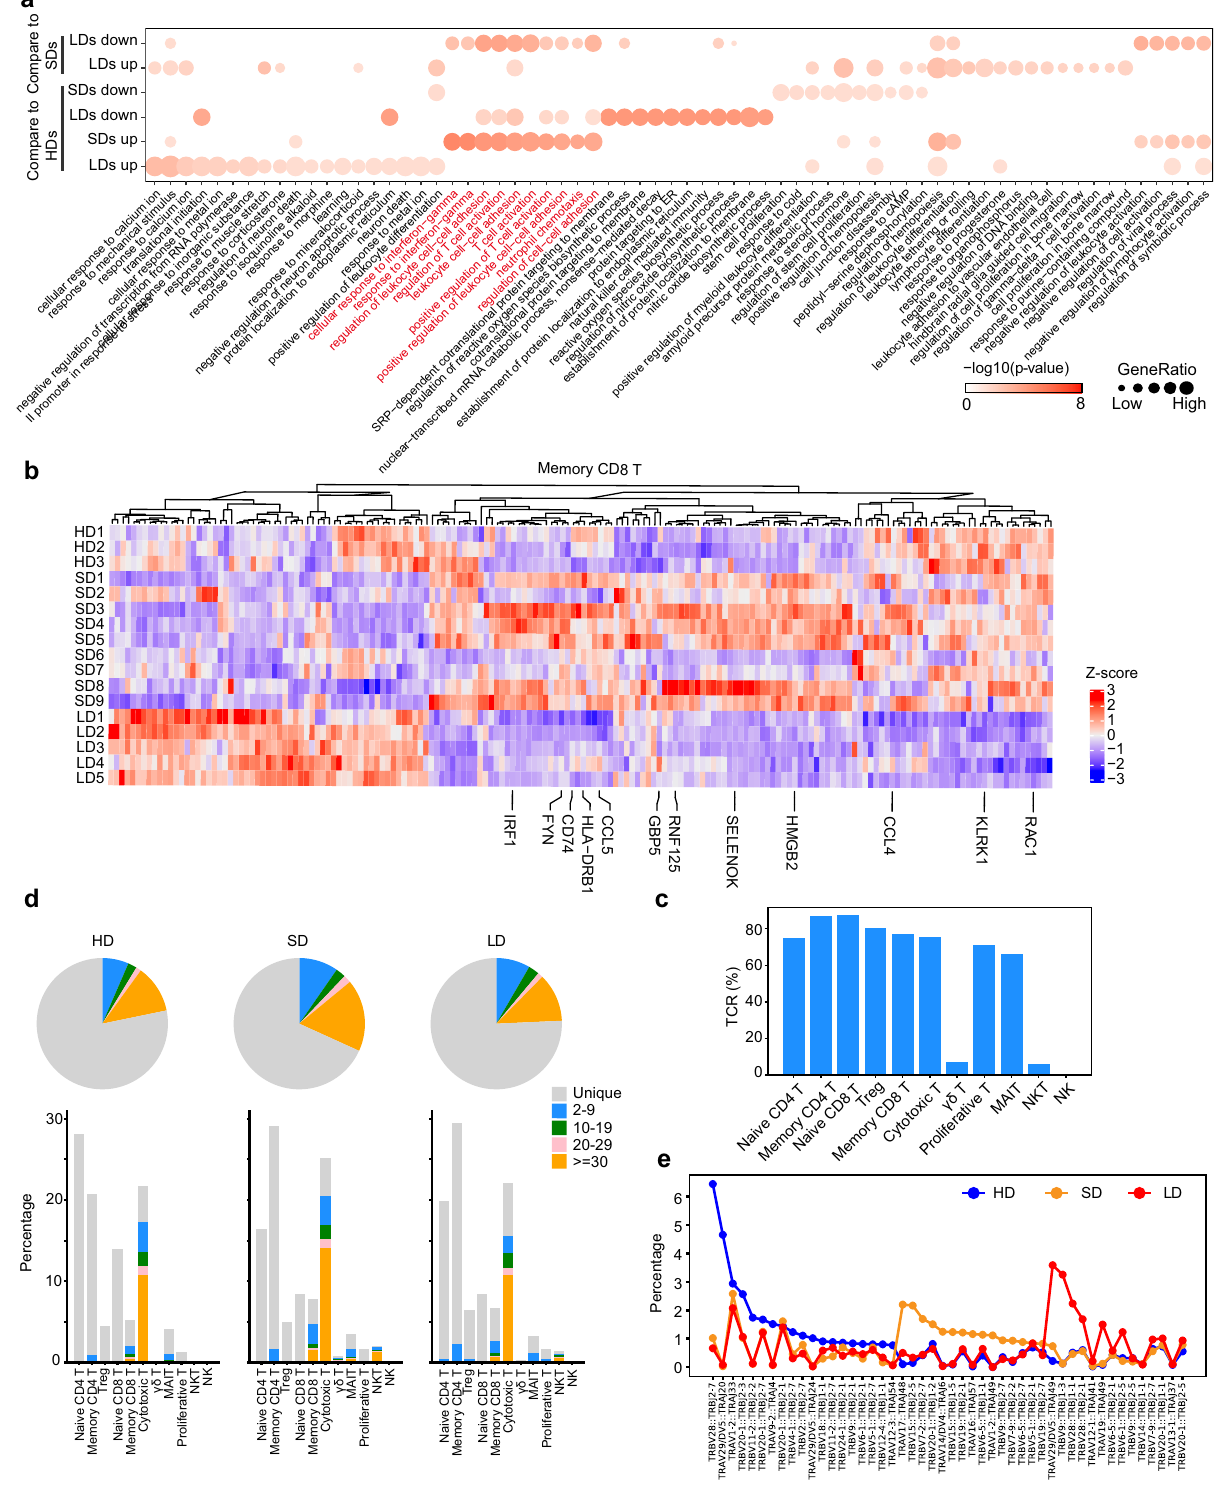
Fig. 5 Molecular features of T cells in LDs and SDs. a Enriched GO pathways of COVID-19 groups in memory CD8 + T cells (top 2 columns: DEGs between LDs and SDs, bottom 4 columns: DEGs for SDs and LDs compared to HDs. Pathway enriched by SDs upregulated genes are labeled in red. The color intensity indicates the enrichment p values and the point size indicates the ratio of gene enrich in each pathway. b Hierarchical clustering of expression of DEGs in memory CD8 + T cells at sample level. The color intensity indicates the relative expression of each gene. c , d The clonal status percentage of T cells and that at each cell type resolution in three groups. e The percentage of selected clonal types in three groups. Source data are provided as a Source Data fi